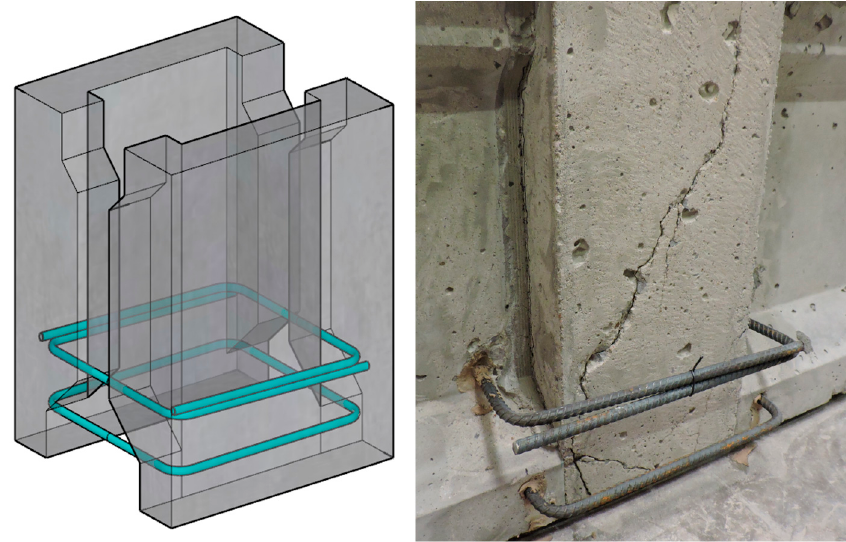
Figure 5. Joint repair reinforcement.